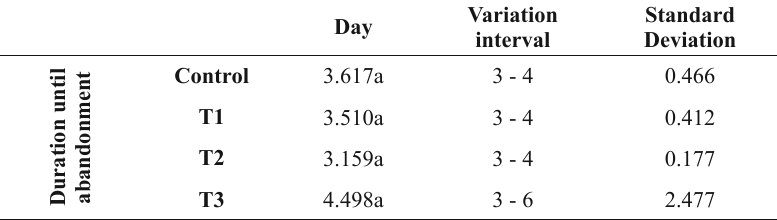
Average duration of the post-embryonic development stages *(days) of larvae of the blow fl y Chrysomya putoria (Wiedemann, 1830) subjected to four treatments with different concentrations of ampicillin and reared in a climatic chamber (30 °C day and 28 °C night, 70 + 10 % RH and 14 h photoperiod).